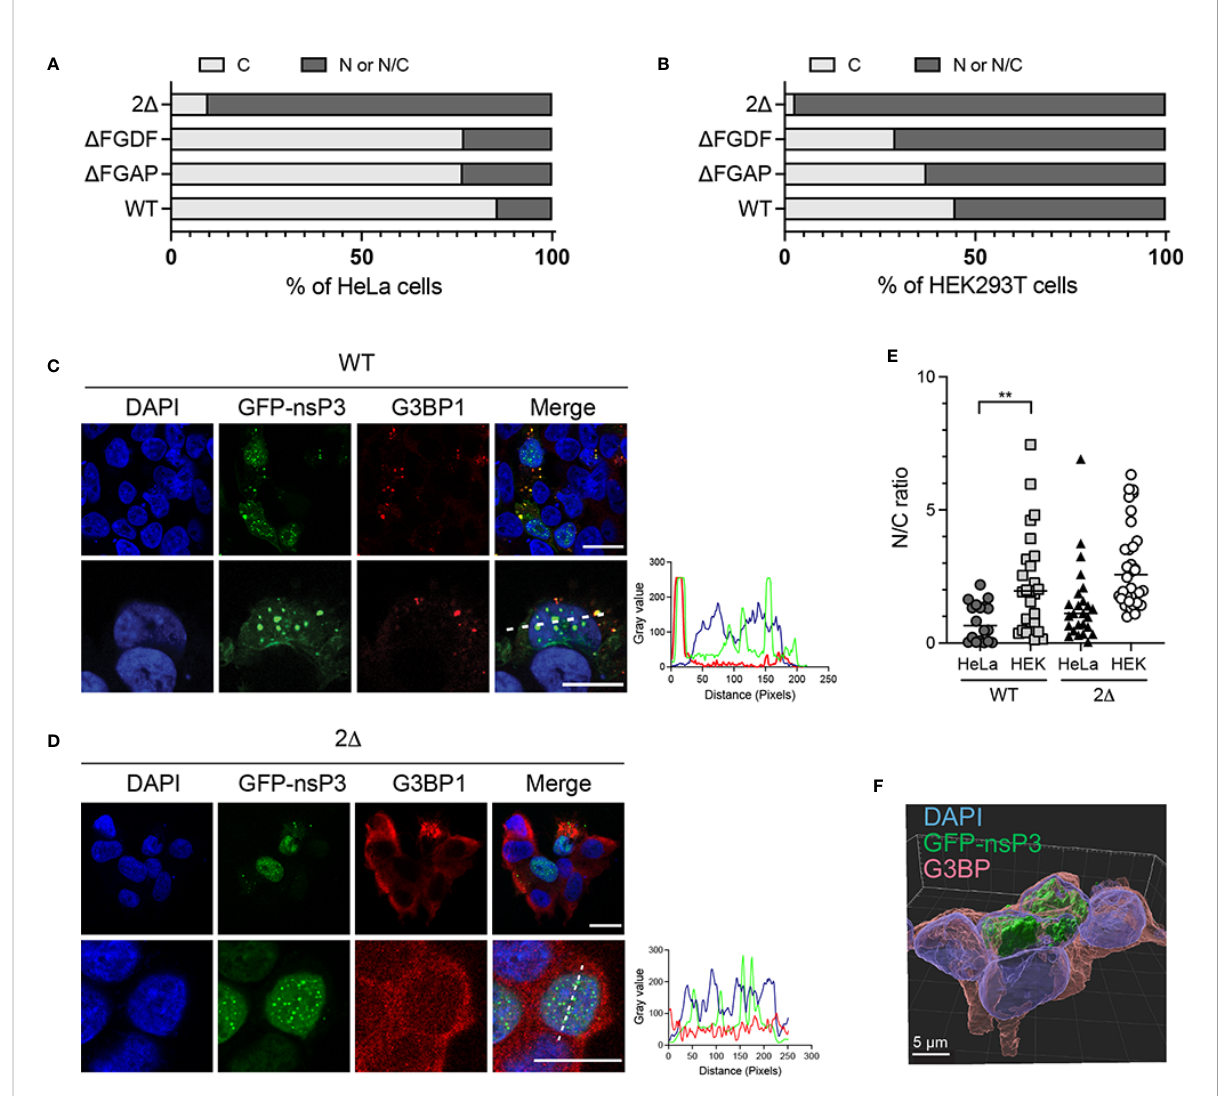
FIGURE 8 Subcellular distribution of WT and mutant GFP-nsP3 is determined by G3BP binding. HeLa cells (A) or HEK293T cells (B) transfected to express GFP-fused WT nsP3, or D FGAP, D FGDF, and 2 D derivatives were examined by confocal microscopy. Fluorescence distribution was classi fi ed as exclusively cytoplasmic (C) , or present at least in the nucleus (N/C). Percentages of cells within each group were plotted (total number of cells ̲ 50 for each condition). Representative confocal images of HEK293T cells expressing the wild-type nsP3 (C) or the 2 D mutant (D) are shown. Scale bars are 20 µm. (E) Nucleus-to-cytoplasm- fl uorescence ratios were calculated from individual cells. (F) Z-stack analysis and 3D image reconstruction of 2 D GFP-nsP3 and G3BP fl uorescence in HEK293T